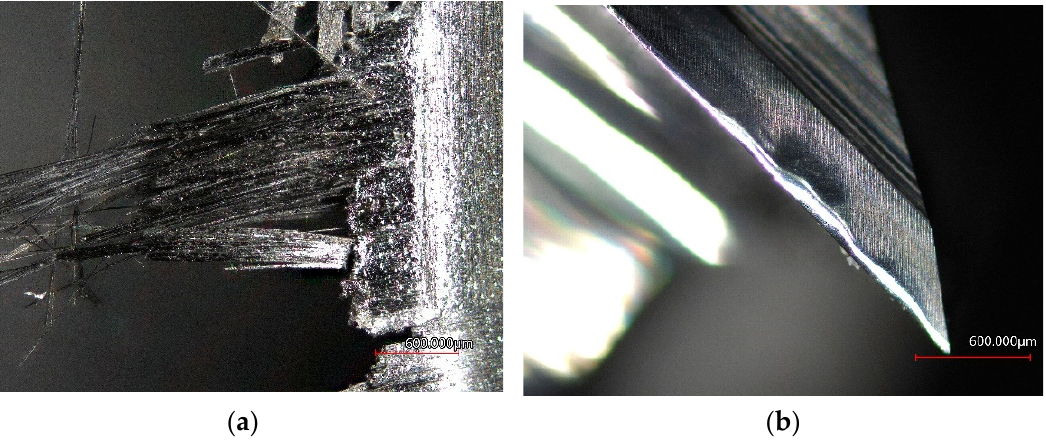
Figure 9. Capture after a tool tooth path of 15 × 165 m. ( a ) Laminate thickness 1 mm; ( b ) A100 milling tool.